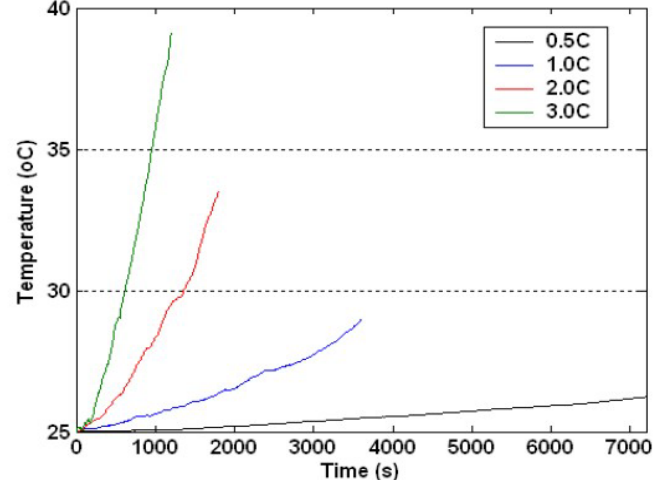
Figure 3. Increase in temperature under different charging